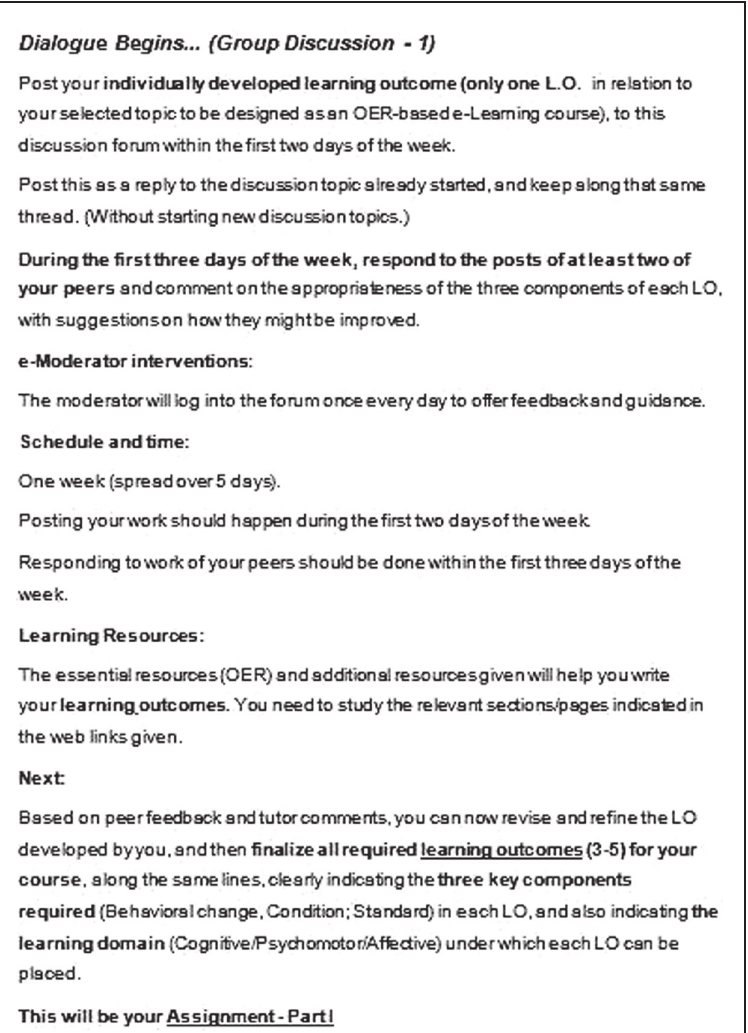
Figure 2. Format of a group discussion forum